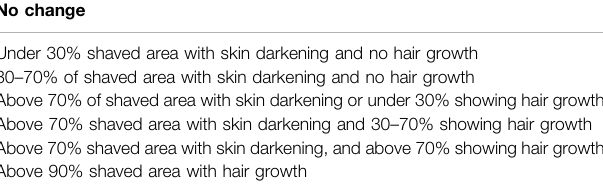
TABLE 1 | Criteria for quanti fi cation of hair regeneration